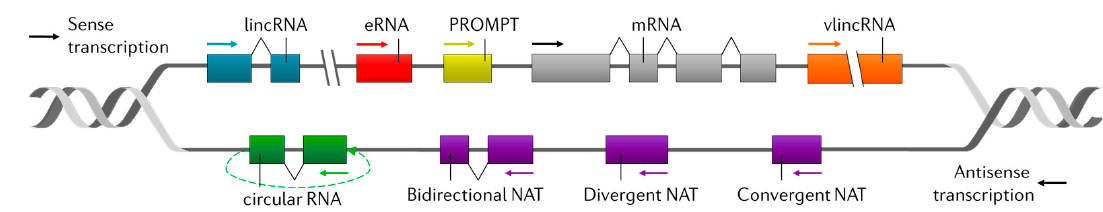
Figure 2. Classification of lncRNAs according to their genomic position. See text for details .